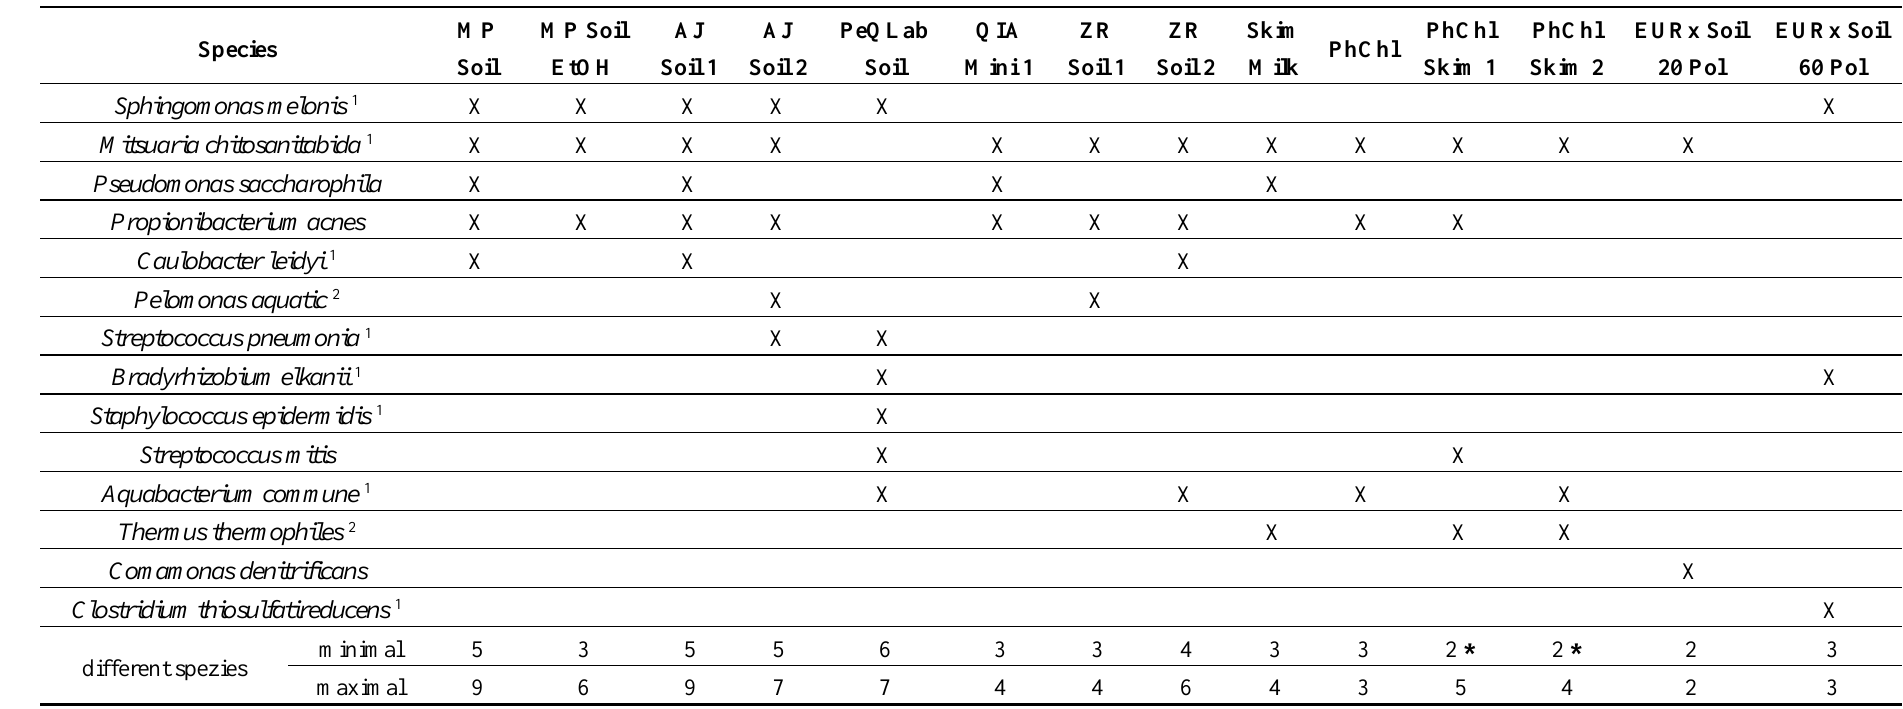
Table 3. Detected species dependent on the applied